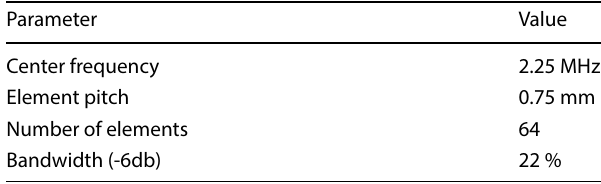
Table 1 Specifications of the simulated phased array